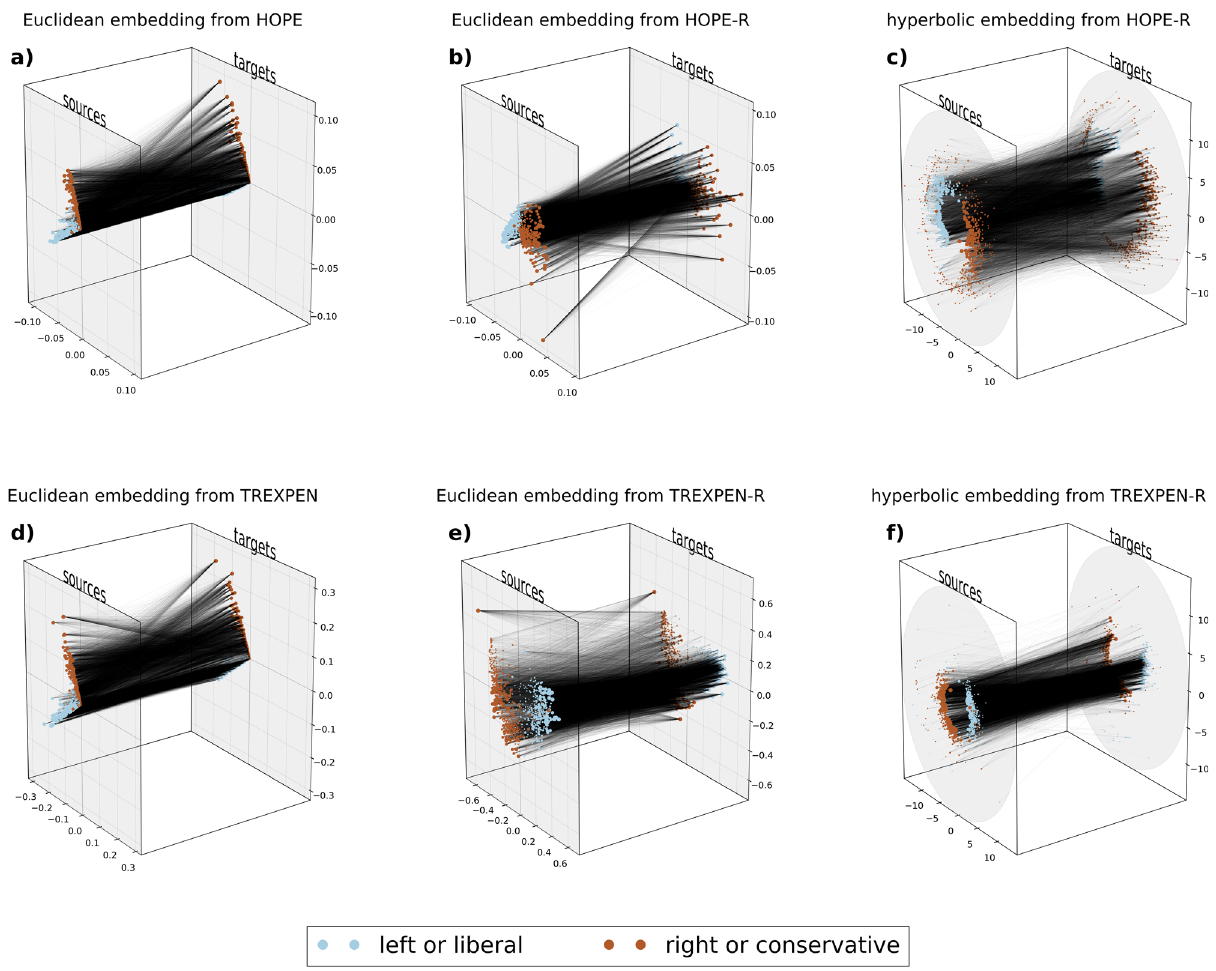
Fig. 4 Two-dimensional embeddings of the network of political blogs. The coordinates obtained for the source and the target representations of the nodes are displayed in separate planes for better visibility. Thus, the links always point from a node on the “ source plane ” to a node on the “ target plane ” . The node colours indicate the political leaning of the corresponding weblog. Larger node sizes in the “ source plane ” and in the “ target plane ” correspond to larger out- and in-degrees, respectively. Panels a – c correspond to embeddings based on Katz proximity, while our exponential proximity was used in the case of panels d – f . Panels a and d show the non-circular Euclidean embeddings created by HOPE and TREXPEN, respectively. Panels b and e depict the circular Euclidean layouts yielded by the HOPE-R and the TREXPEN-R variants, while panels c and f present the hyperbolic embeddings obtained from these using our Euclidean-hyperbolic conversion method